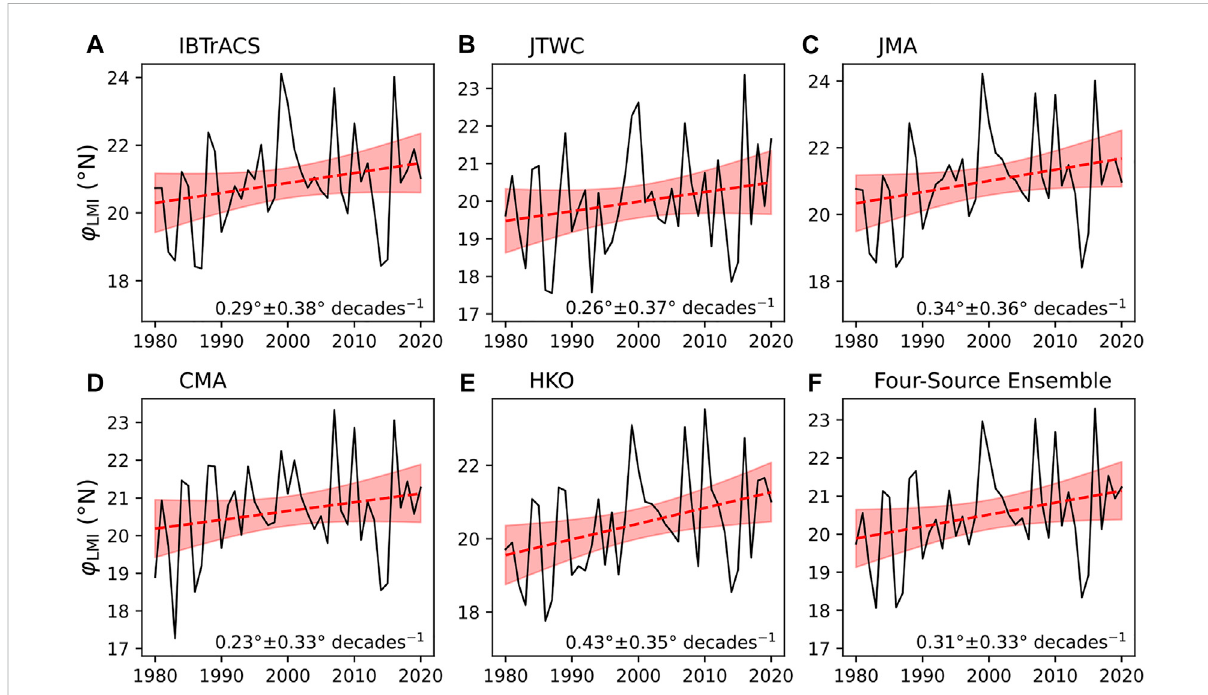
FIGURE 1 Migration of the location of LMI. Time series of annual-mean φ LMI calculated from various best-track historical data over the WNP. (A – F) shows datafromdifferentsources,where (A) isIBTrACS, (B) isJTWC, (C) isJMA, (D) isCMA, (E) isHKOand (F) istheensemblemeanofJTWC,JMA,CMAand HKO. Linear trend lines (dashed) are shown with their 95% two-sided con fi dence intervals (shaded), which are also given by the annotated values.